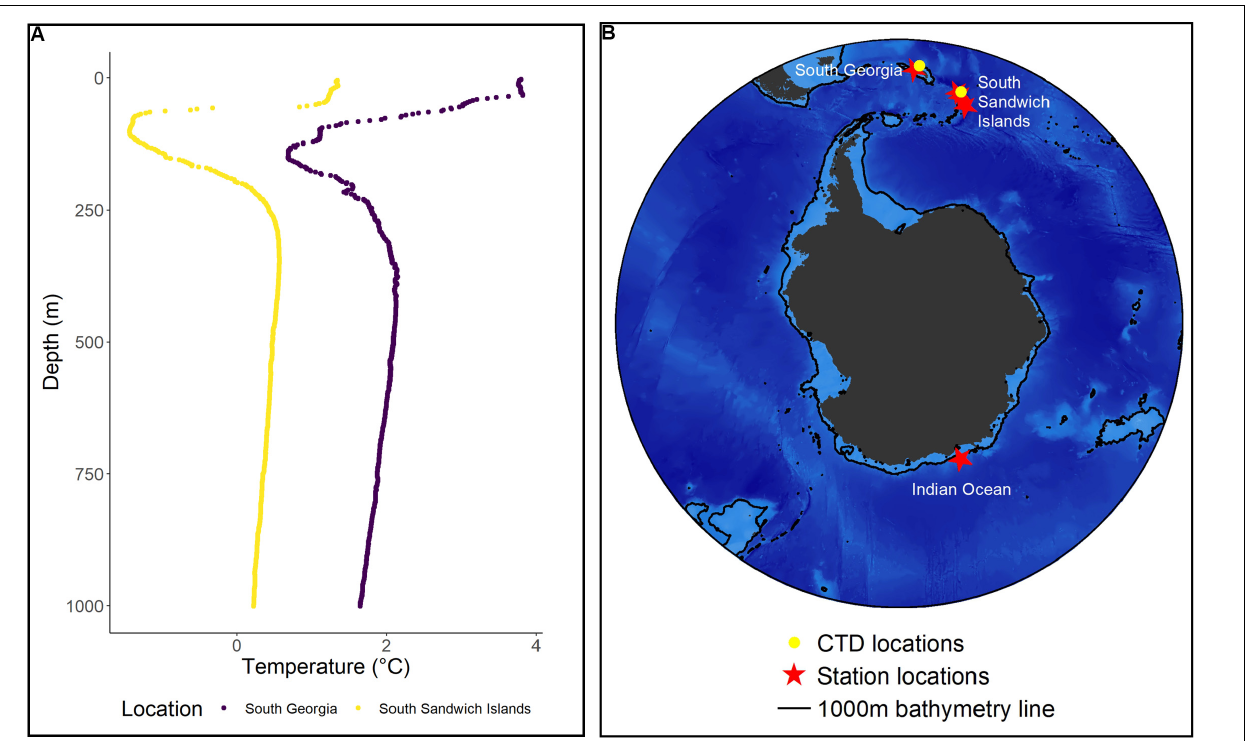
FIGURE 1 | Sample locations for field and laboratory experiments as well as temperature details from the field experiments. (A) Temperature profiles collected from CTD casts at South Georgia and the South Sandwich Islands during the cruise on which the field experiments were undertaken. (B) The station locations at which gravid females were captured for our field and laboratory experiments. Field samples were collected from the Atlantic sector. Laboratory samples were collected from the Indian Ocean sector of the Southern